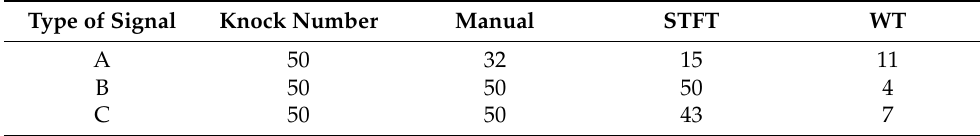
Table 7. The misdetection numbers of the different methods. Type of Signal Knock